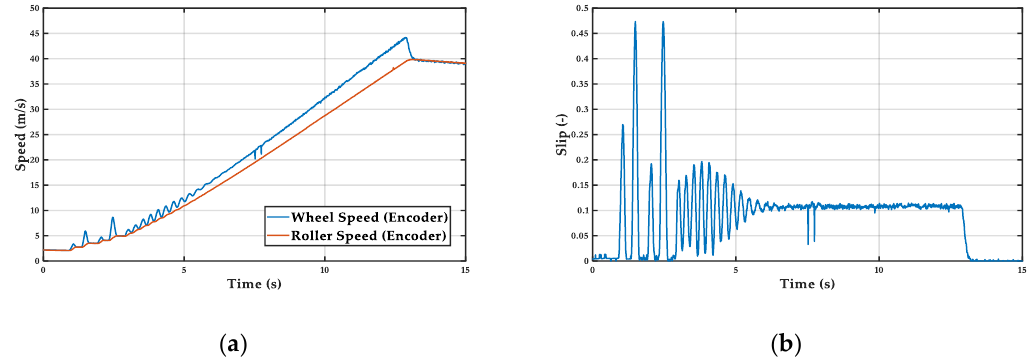
Figure 10. PID controller: ( a ) wheel and roller speed, ( b ) wheel slip.